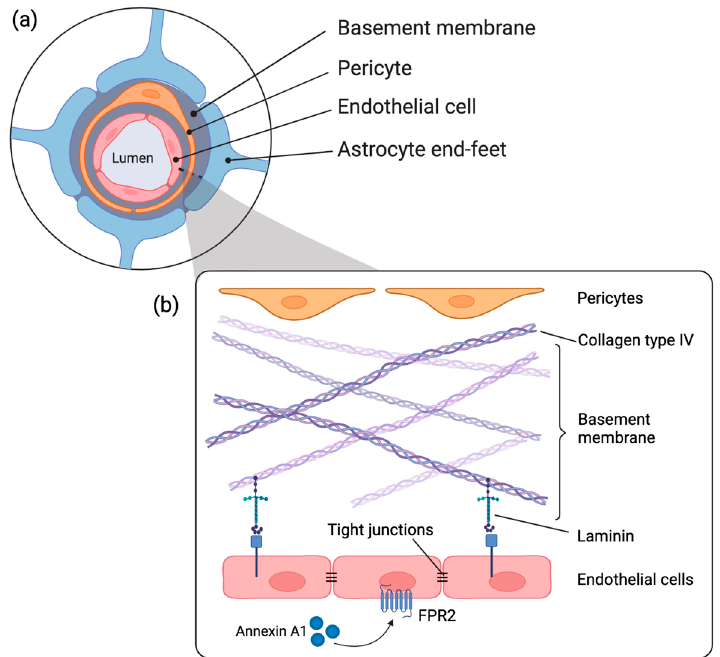
Figure 1. ( a ) Schematic representation of the NVU including vascular cells (endothelial cells, pericytes), basement membrane, and astrocyte end-foot in the CNS; ( b ) structural illustration of the basement membrane components including laminin and collagen type IV, endothelial cells and the pro-resolving signature of Annexin A1 binding to the formyl peptide receptor 2 (FPR2). Created with Biorender.com.